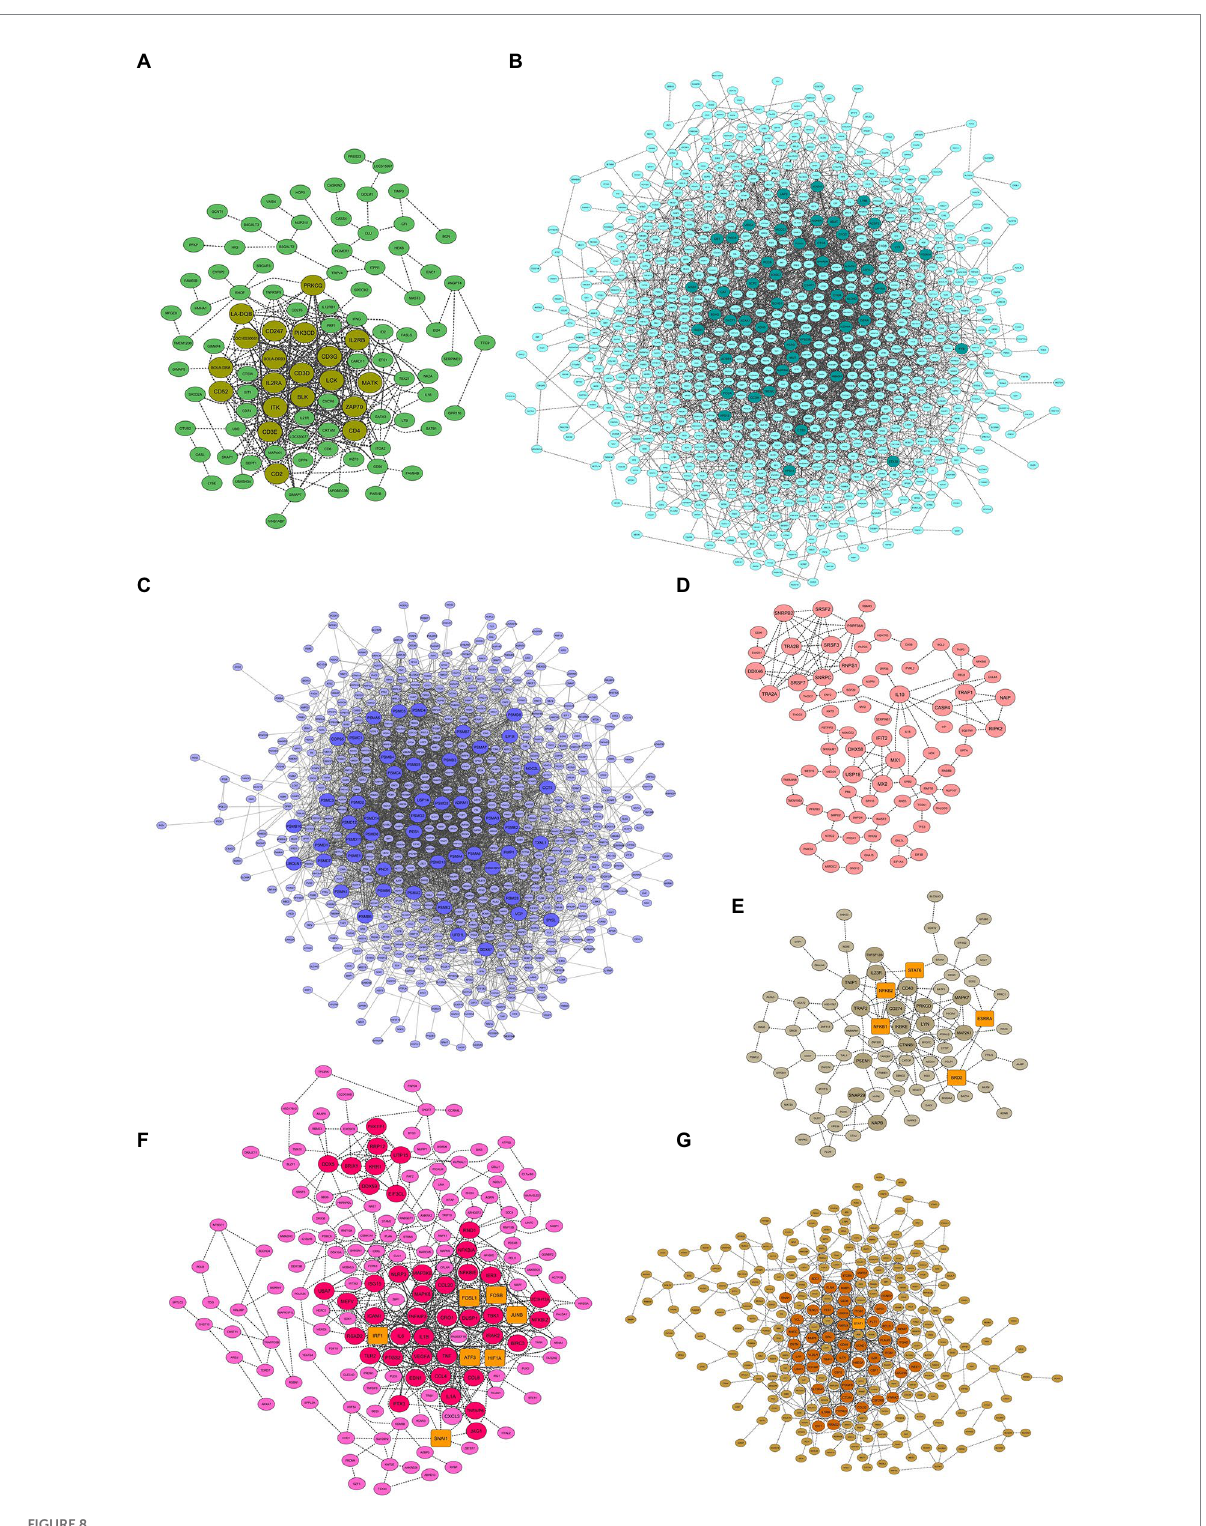
FIGURE 8 PPI network derived from co-expressed hub genes of the (A) green, (B) turquoise, (C) blue, (D) salmon, (E) tan, (F) pink, and (G) brown modules. Large circles and orange round rectangles represent hub-central genes and TFs,